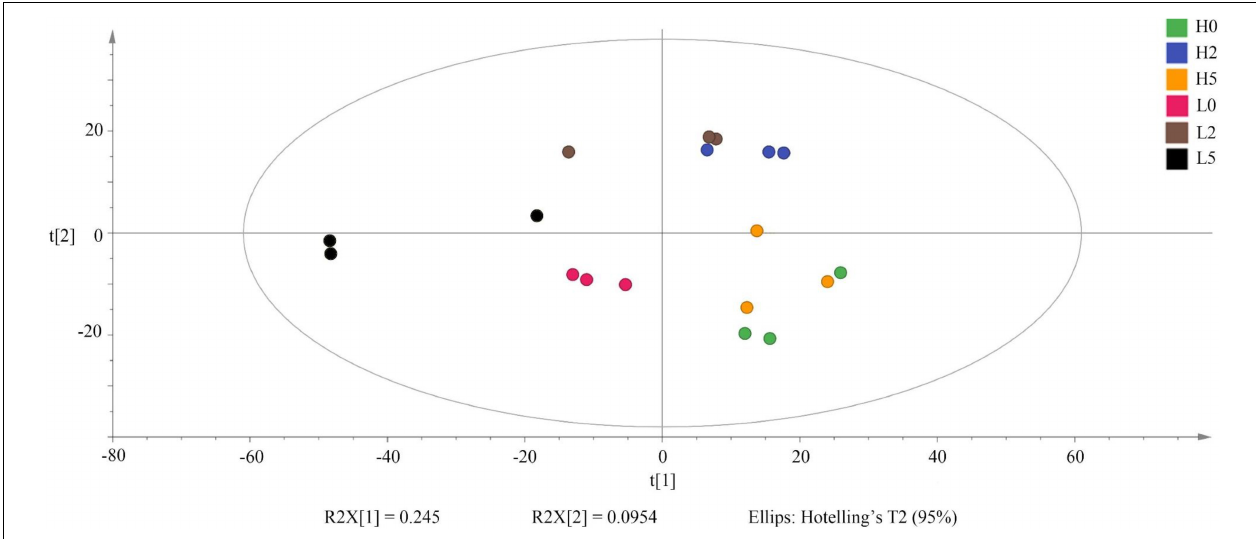
FIGURE 5 | Principal component analysis of metabolites in whole-plant corn silages ( n = 3). H, ensiled whole corn plants with a high moisture content (680 g/kg) harvested at the one-third milk-line stage; L, ensiled whole corn plants with a low moisture content (620 g/kg) harvested at the two-thirds milk-line stage.